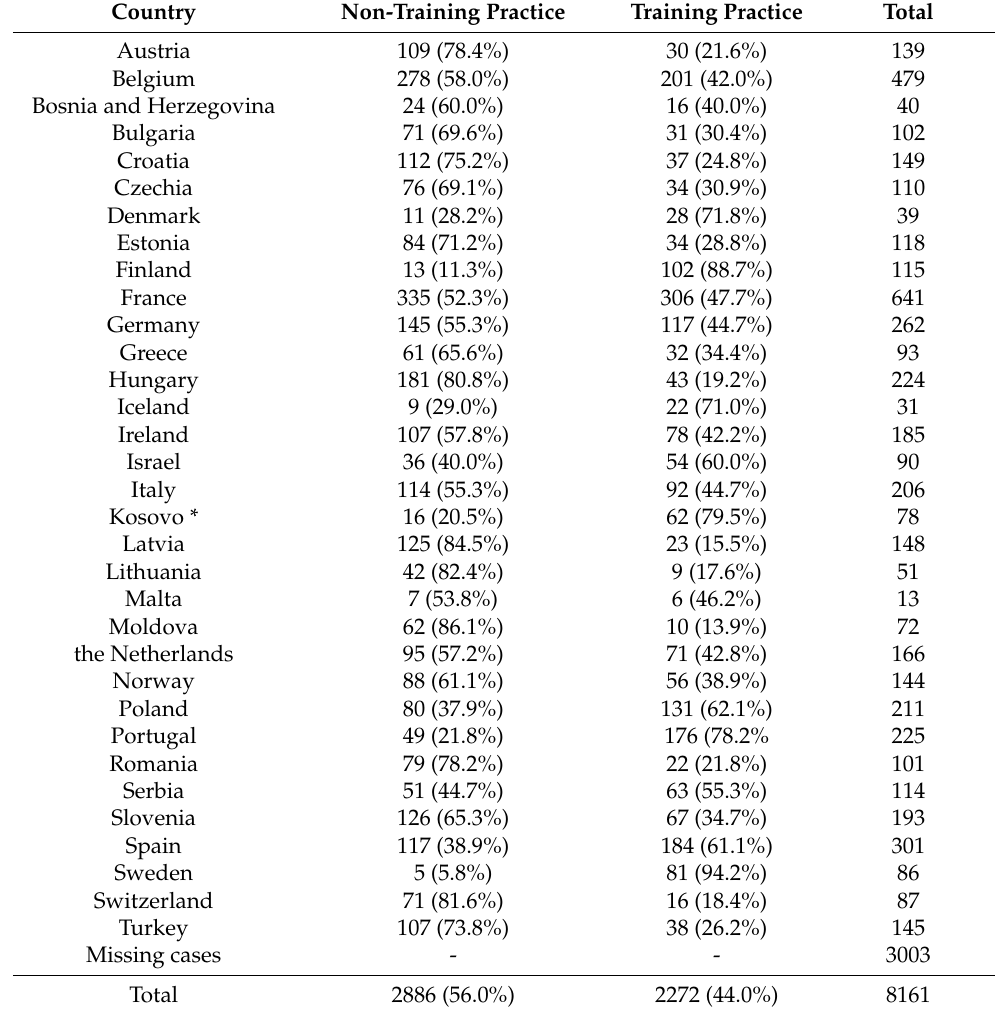
Table 1. Distribution of training practices across countries, total and valid